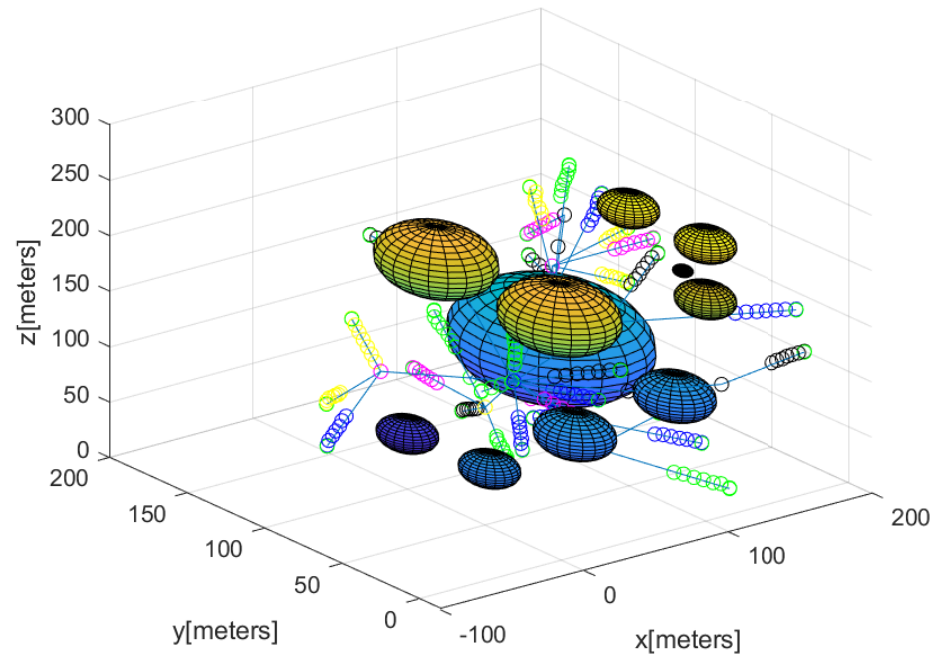
Figure 6. Every UUV’s maneuver until t = 20 s has passed (one MC simulation). Every UUV’s maneuver is illustrated as circles with a distinct color. We also plot the tree graph T (blue line segments) generated at time 0. Obstacles are plotted with spheres.